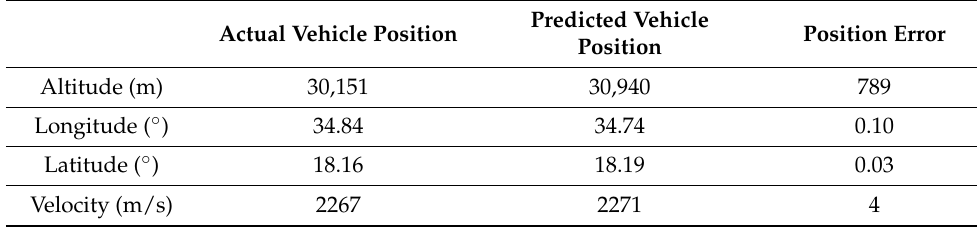
Table 4. Error statistics of Monte Carlo simulation (90 percent probability).